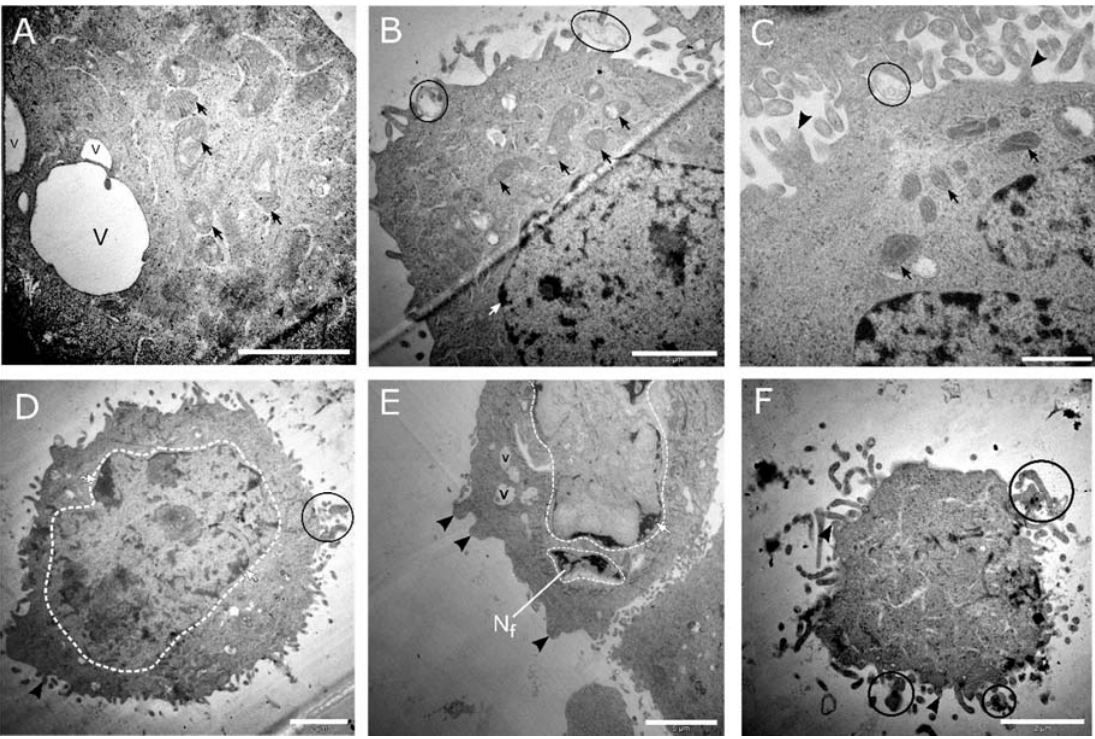
Figure 9. Transmission electron micrographs of CaSki cell cultures treated with 100 and 1000 ng/mL cholecalciferol. The micrographs ( A – C ) represent cultures treated with 100 ng/mL cholecalciferol, displaying mitochondria with dilated cristae (black arrows), apoptotic bodies (encircled in black), cell membrane blebbing (black arrowhead), and isolated vacuoles (v). Micrographs ( D – F ) represent cultures treated with 1000 ng/mL cholecalciferol, which show features of nuclear apoptosis, including nuclear fragmentation (N f ) and various stages of karyolysis (encircled white dashed line), membrane budding (black arrowheads), isolated vacuoles (v), and the presence of apoptotic bodies (encircled in black). ( F) Terminal apoptotic events, demonstrating a shrunken cell with an amorphous cytoplasm surrounded by multiple apoptotic bodies (encircled in black). Scale bars: ( A , B , D , F ) = 2 μ m and ( C ) = 1 μ m.